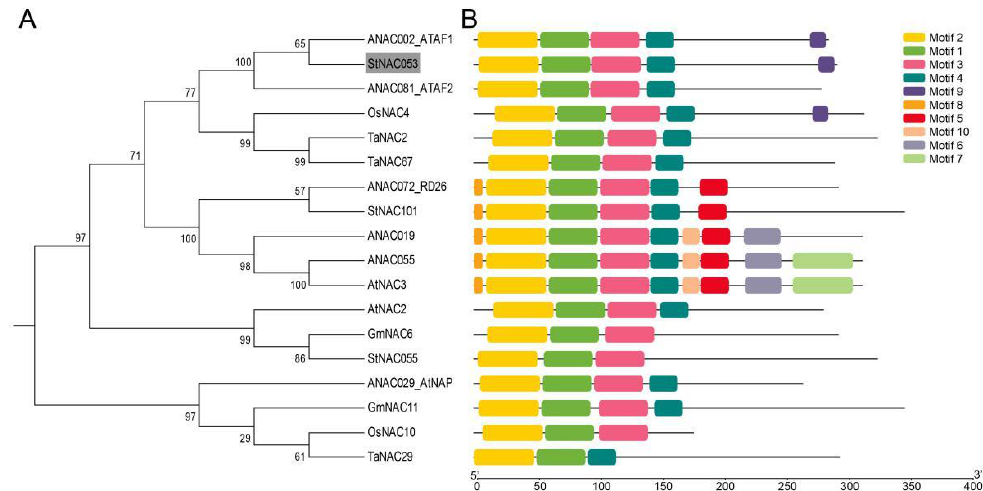
Figure 2. Phylogenetic analysis and motif organizations of StNAC053 and homologous NAC proteins. ( A ) The phylogenetic tree was generated from the alignment of StNAC053 and other plant NAC proteins using the neighbor-joining (NJ) method. ( B ) The motif organizations were predicted using MEME.